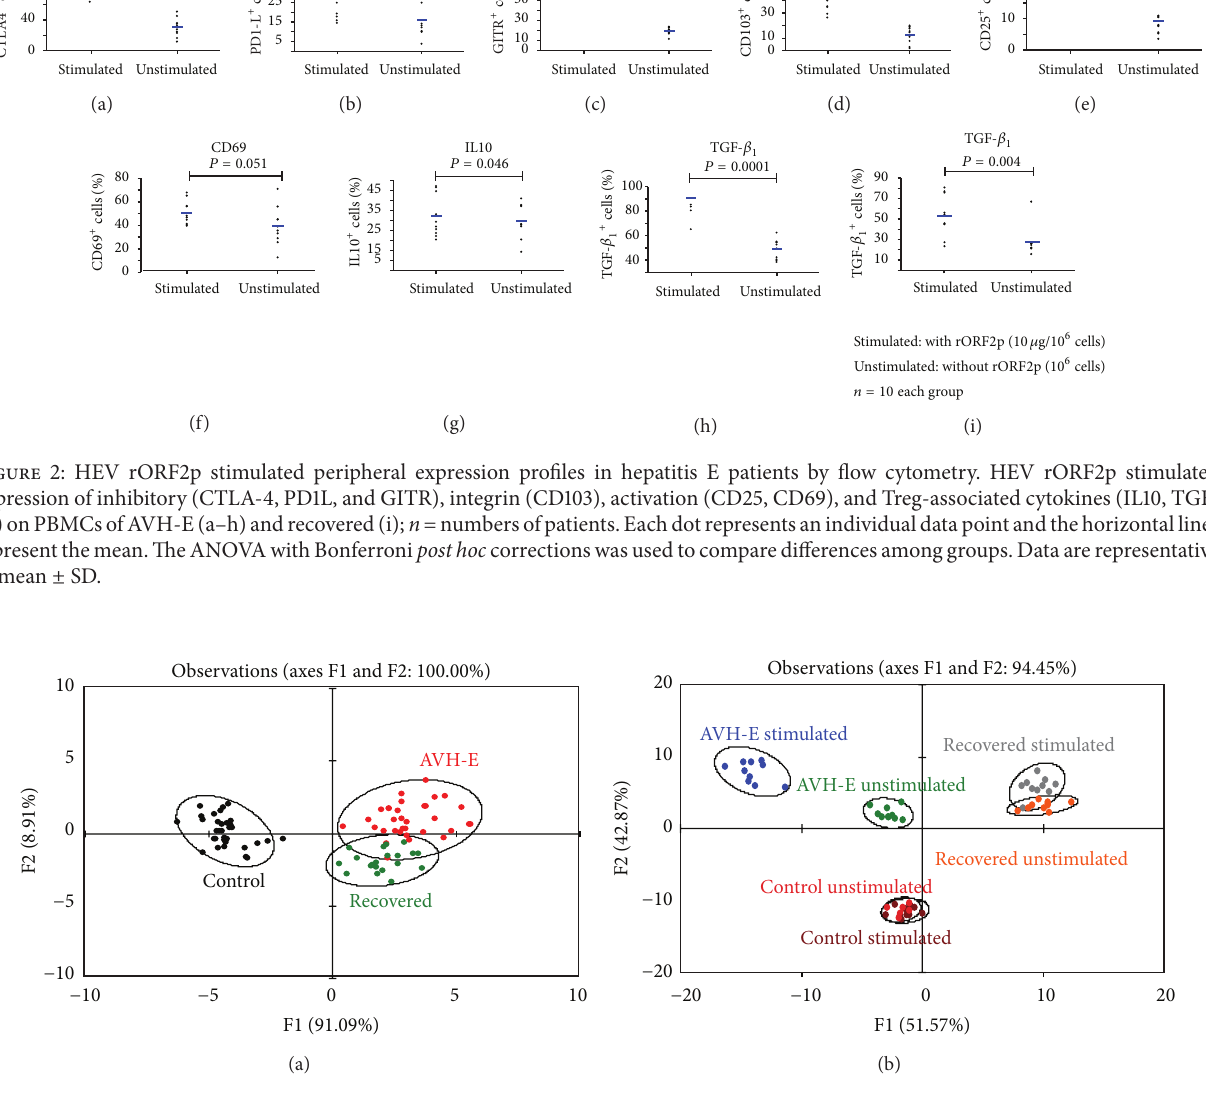
Figure 3: Clustering of markers on na¨ıve and HEV rORF2p stimulated PBMCs of hepatitis E patients and healthy controls. A graphical representation of the discriminatory potential of discriminant function analysis (DFA). The analysis was used to select variables that maximally discriminate among the (a) discriminant function analyses of unstimulated PBMCs, AVH-E (red), recovered (green), and controls (black). Circles represent the 95% confidence eclipses. (b) Discriminant functions analysis of HEV rORF2p stimulated PBMCs. AVH-E stimulated (blue), AVH-E unstimulated (green), stimulated recovered (grey), unstimulated recovered (orange), stimulated controls (brown), and unstimulated controls (red). Circles represent the 95% confidence